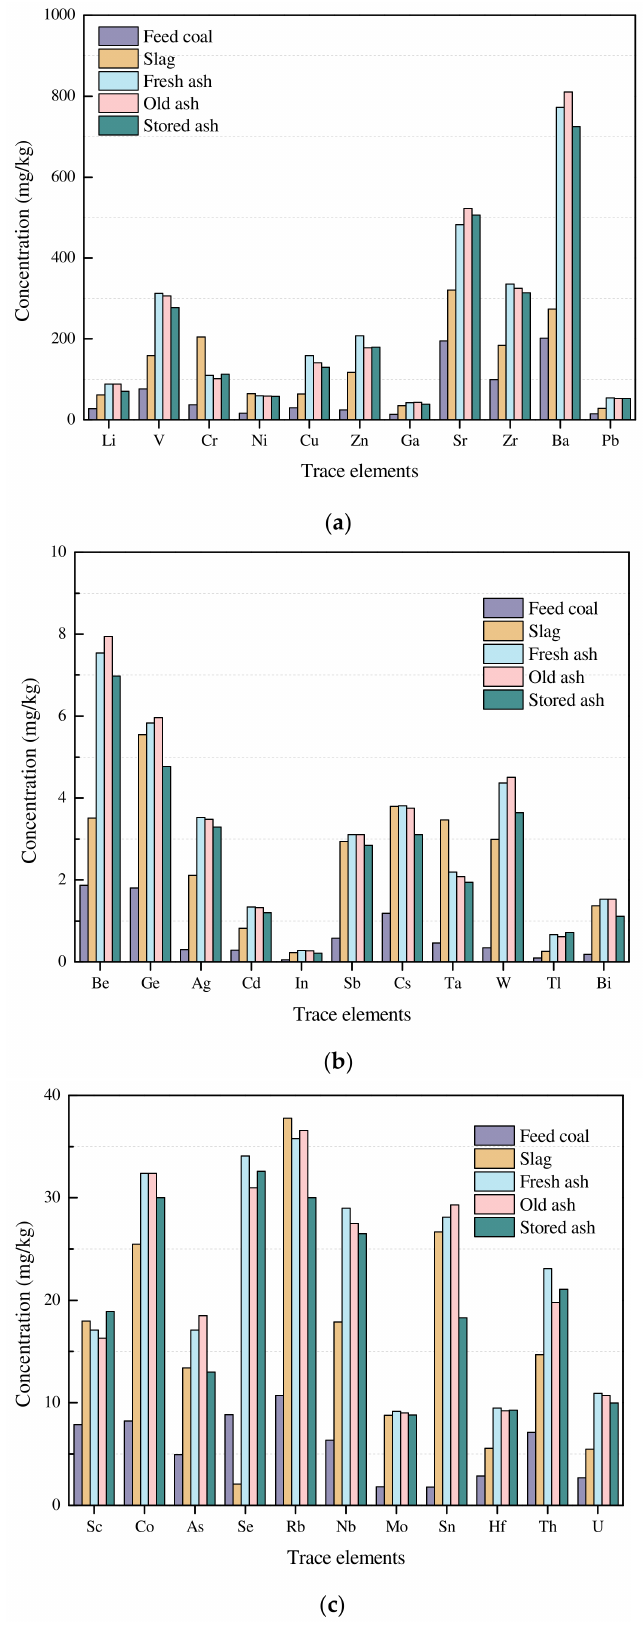
Figure 6. Comparison of trace elements with concentrations lower than 1000 mg/kg ( a ), 10 mg/kg ( b ), and 40 mg/kg ( c ) in feed coal, slag, fresh ash, old ash, and stored ash from the TY power